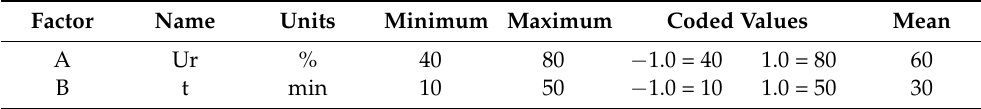
Table 2. Coded parameters in